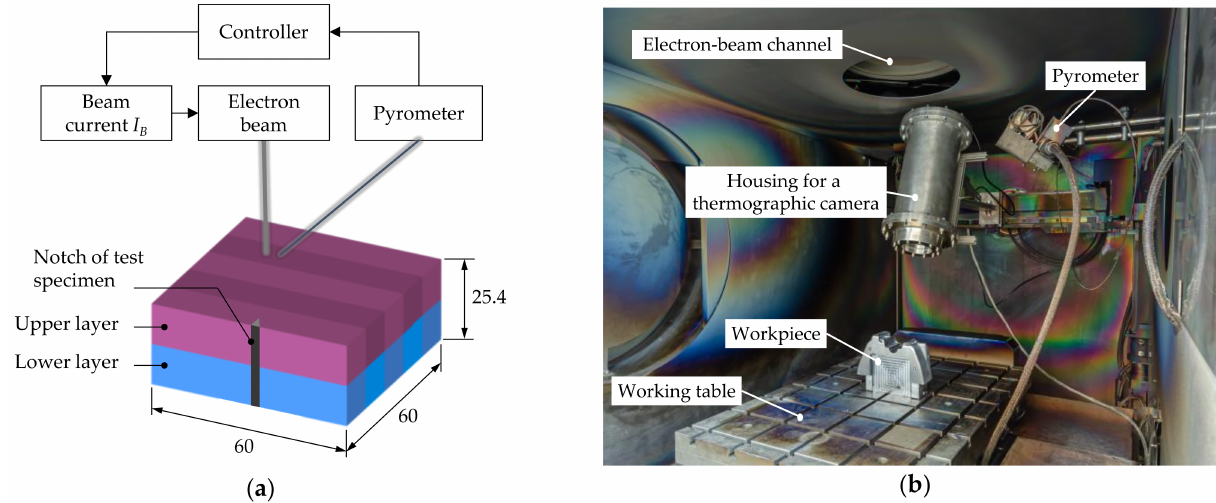
Figure 4. Schematic simple block diagram of the closed-loop control ( a ) and the real setup of the electron-beam machine ( b ).